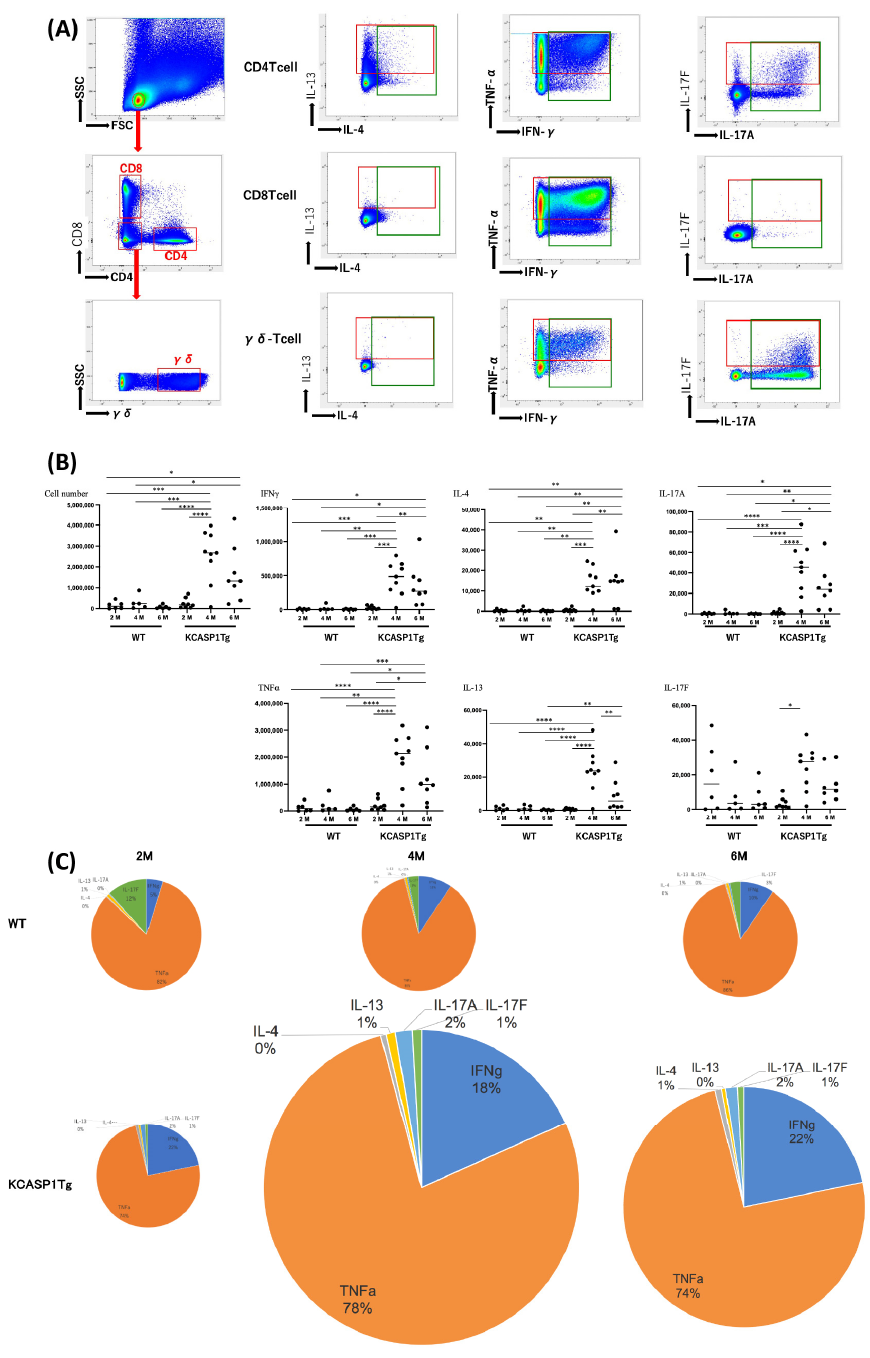
Figure 1. Cytokine production by T helper cells. ( A ) The plots represent the production of specified cytokines by the three types of T cells namely, CD4 T, CD8 T, and γδ -T cells, in 4-month-old KCASP1Tg mice. CD4T cells produce IL-13 and a small amount of IL-4; TNF α -producing cells are predominant for type 1 cytokines, especially from CD8T cells and CD4T cells; CD4T cells are divided into IL-17A alone, IL-17F alone, and IL-17A/F-producing cells. On the other hand, γδ T cells do not produce IL-17F alone. ( B , C ) The number of indicated cytokine-producing T cells was measured at 2, 4, and 6 months of age (M). All cytokine-producing cells were high in number at the peak of the dermatitis at 4 months of age, with a decreasing trend in cell number at 6 months of age when the skin rash became chronic. ( C ) Pie chart of the data shown in ( B ). The size of the graph in ( C ) reflects the total number of T helper cells. Asterisks indicate a significance difference based on a one-way ANOVA and Tukey’s multiple comparison test (*, p < 0.05; **, p < 0.01; ***, p < 0.001; ****, p <